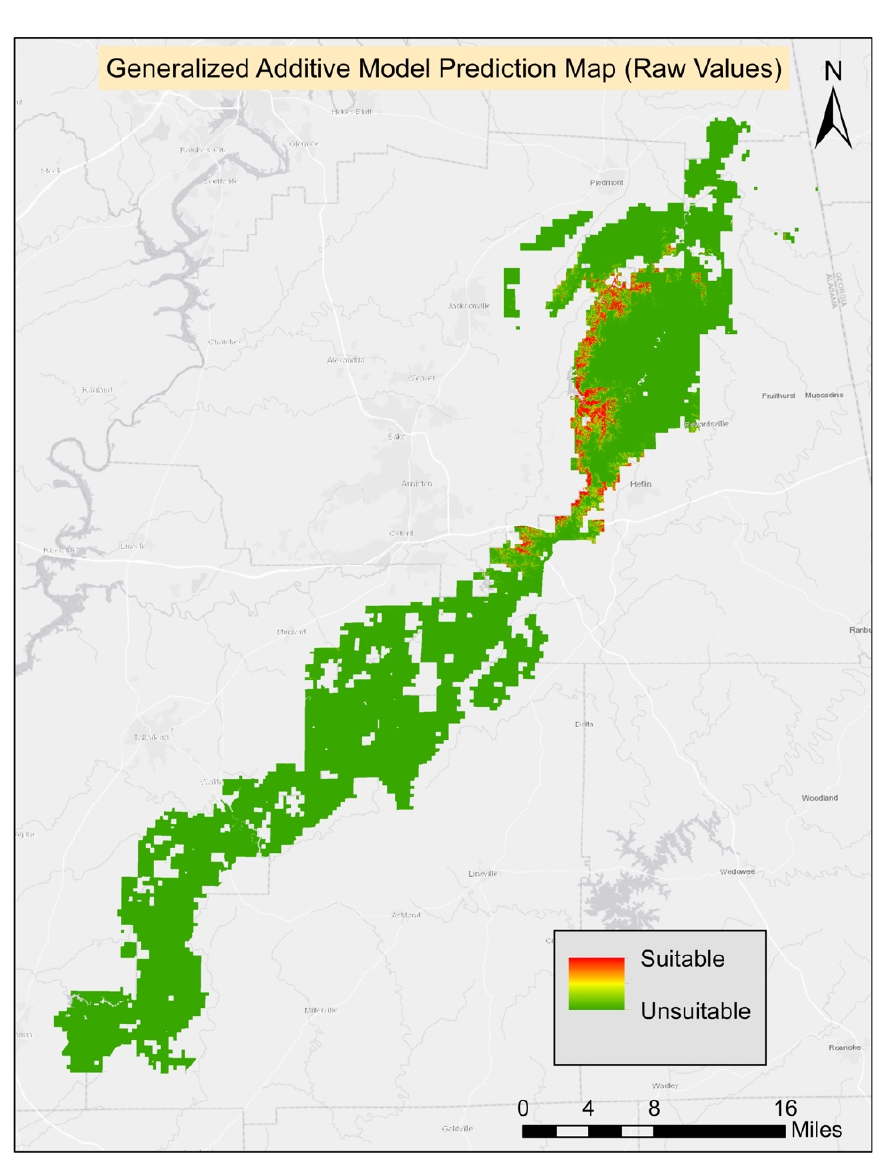
Figure A3. Xerophyllum asphodeloides (turkeybeard) Generalized Additive Model habitat suitability map.